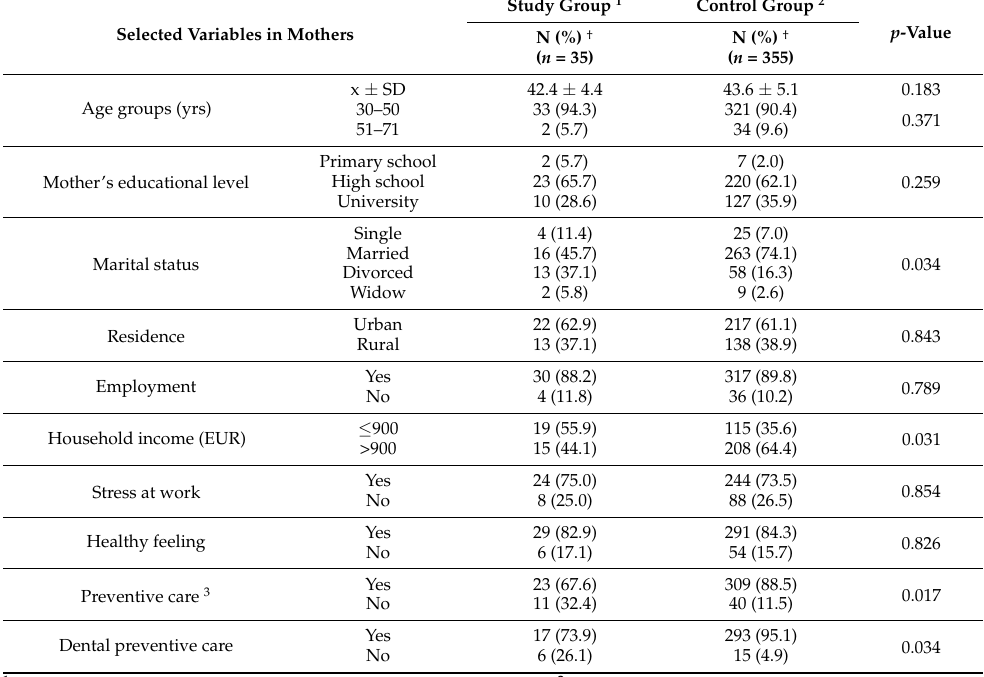
Table 3. Characteristics of selected variables in mothers associated with non-attendance at dental preventive care in the sample of adolescents ( n = 390)